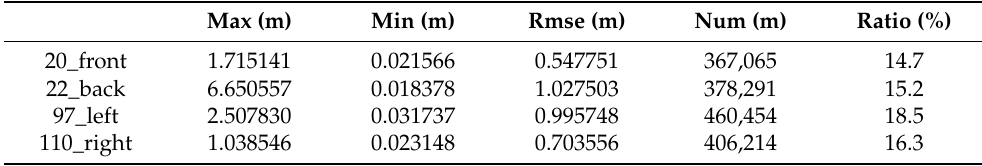
Table 4. Absolute trajectory error of critical values in four directions.